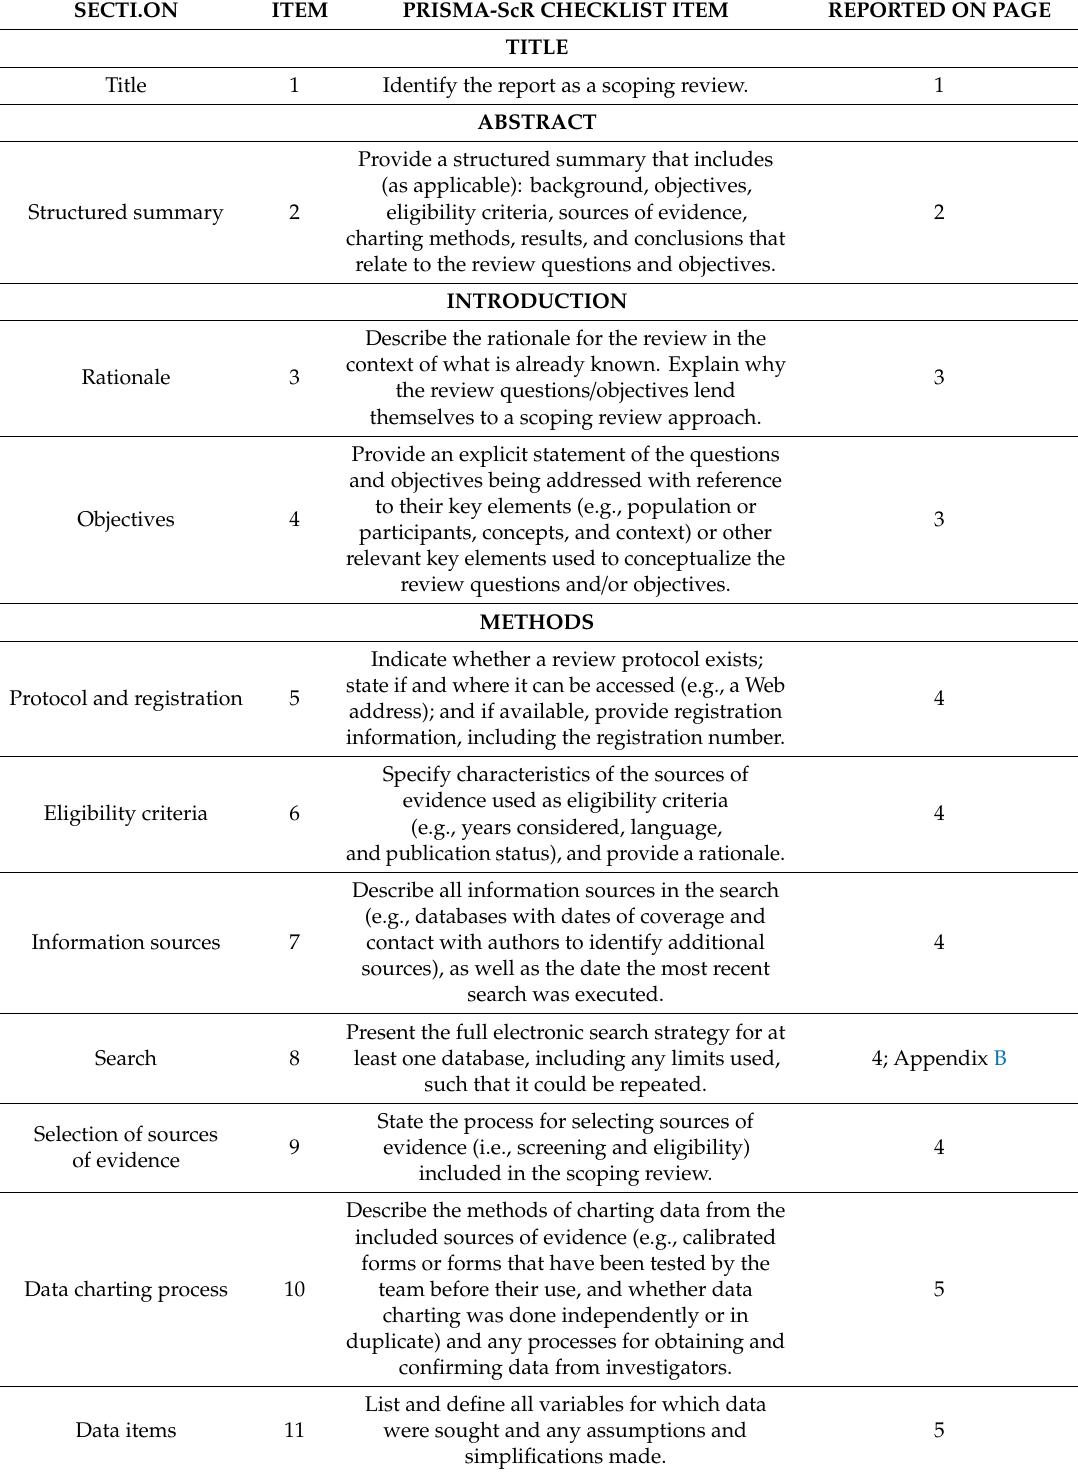
Table A1. PRISMA-Scoping Review (ScR) Checklist Preferred Reporting Items for Systematic reviews and Meta-Analyses extension for Scoping Reviews (PRISMA-ScR)